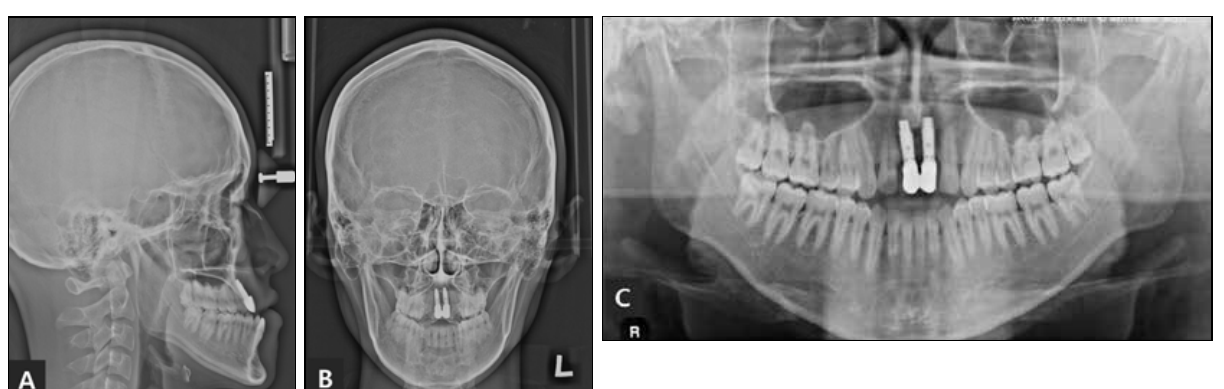
Means and SDs of normal Korean male adults.